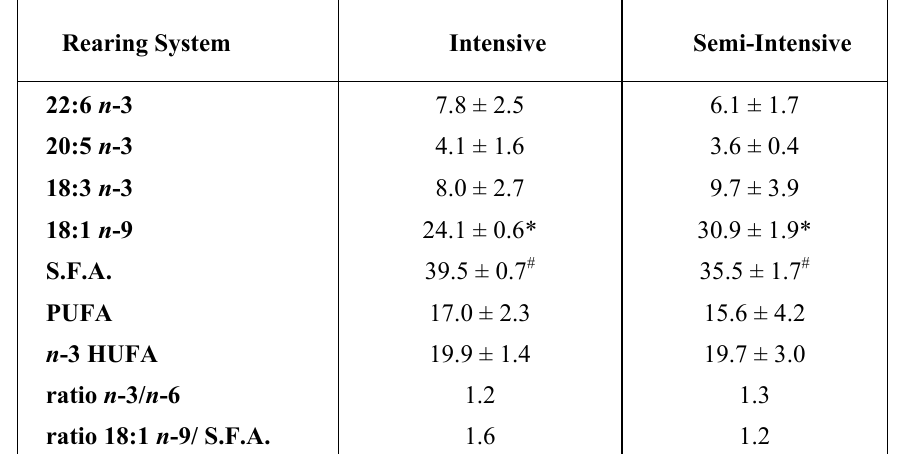
Table 3. Percentage and standard deviations of fatty acids in lipid fractions (intensive and semi-intensive specimens), calculated by 13 C-NMR spectroscopy. (S.F.A.: saturated fatty acids; PUFA: polyunsaturated fatty acids; n-3 HUFA: highly unsaturated fatty acids). Each value is average of 3 replicates. Significant differences in means are indicated by ‘*’ (p-value 0.004) or ‘#’ (p-value 0.02) based on a t-test for independent samples. Homogeneity of variances is always satisfied at a p-value of